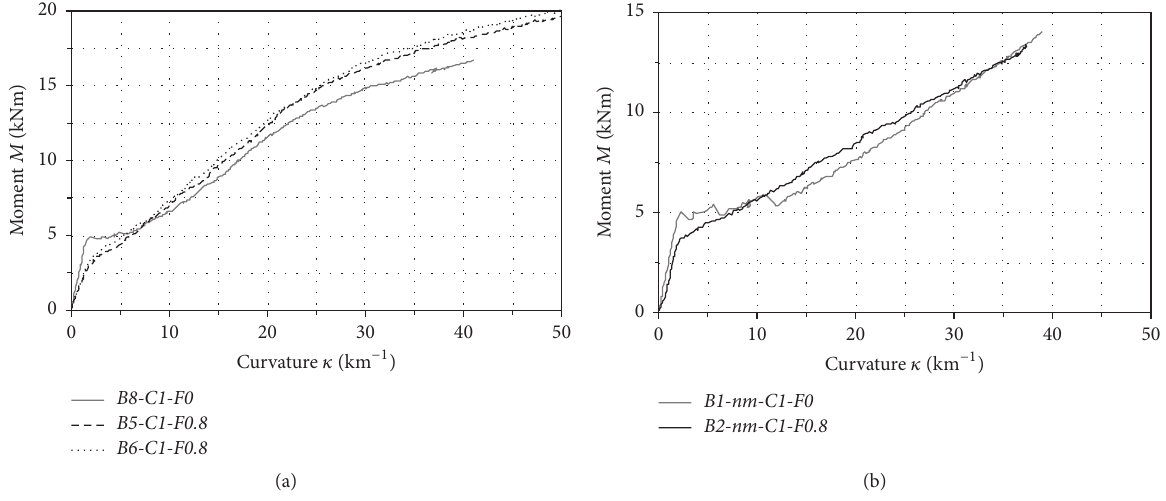
Figure 12: Moment-curvature diagrams of the beams reinforced with steel (a) and GFRP (b)